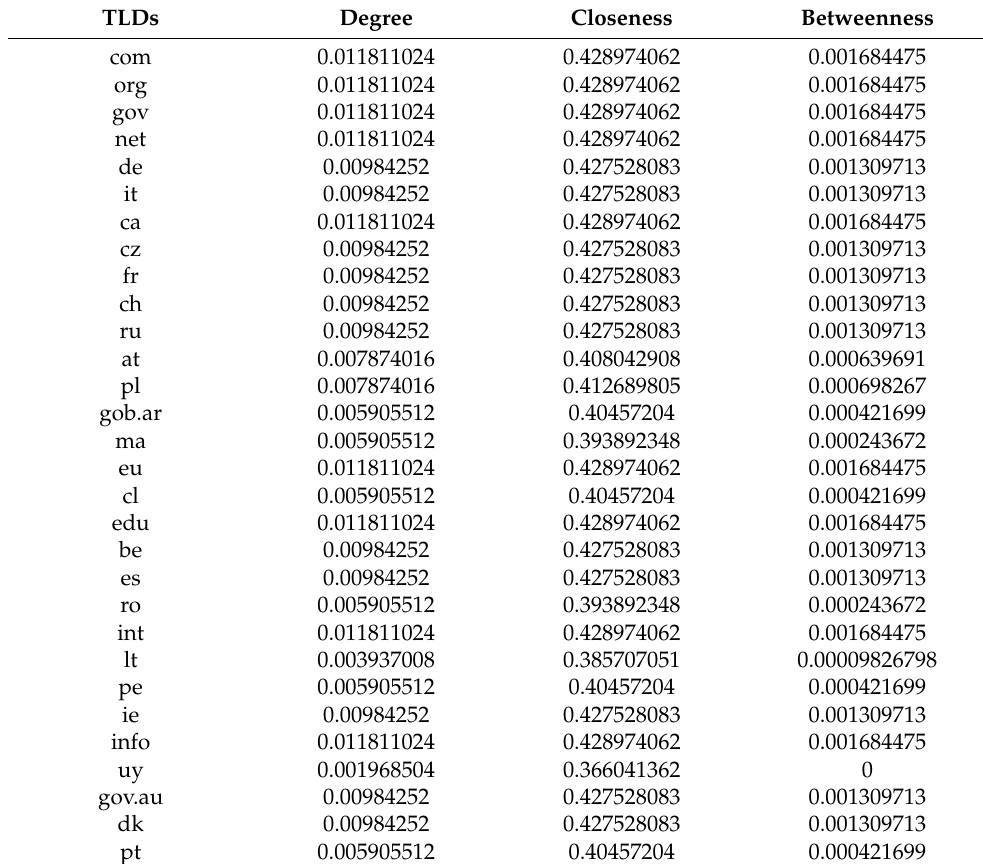
Table 2. Top 30 TLDs in the COVID-19 information network, based on the types of